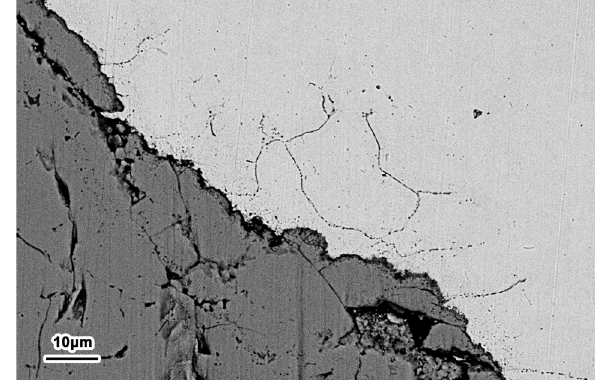
Figure 7: Microscopic morphology of the microcracks along the grain